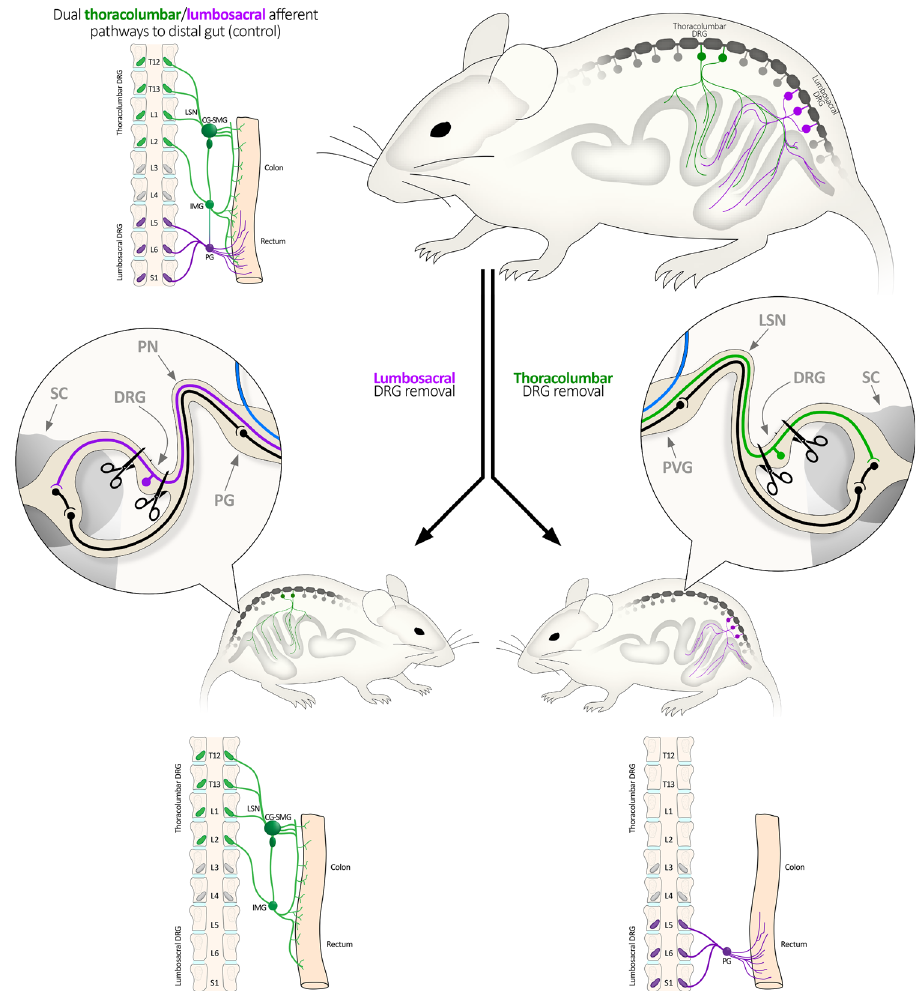
Fig. 1 Schematic diagram showing types of DRG-lesioned mice created in this study. Two major spinal afferent populations innervate the colon and rectum. They arise from the thoracolumbar DRG and the lumbosacral DRG. To study their functions, mice lacking either pathway were created by bilateral removal of the L5-S1 DRG (shown left), or the T13-L1 DRG (right). Unilateral removal of T13-L2 was used to study the uterine horns, allowing contralateral internal controls to be used. CG-SMG Celiac-superior mesenteric ganglia, IMG inferior mesenteric ganglion, LSN lumbar splanchnic nerve, PG pelvic ganglia, PN pelvic nerve, PVG prevertebral ganglion, DRG dorsal root ganglia, SC spinal